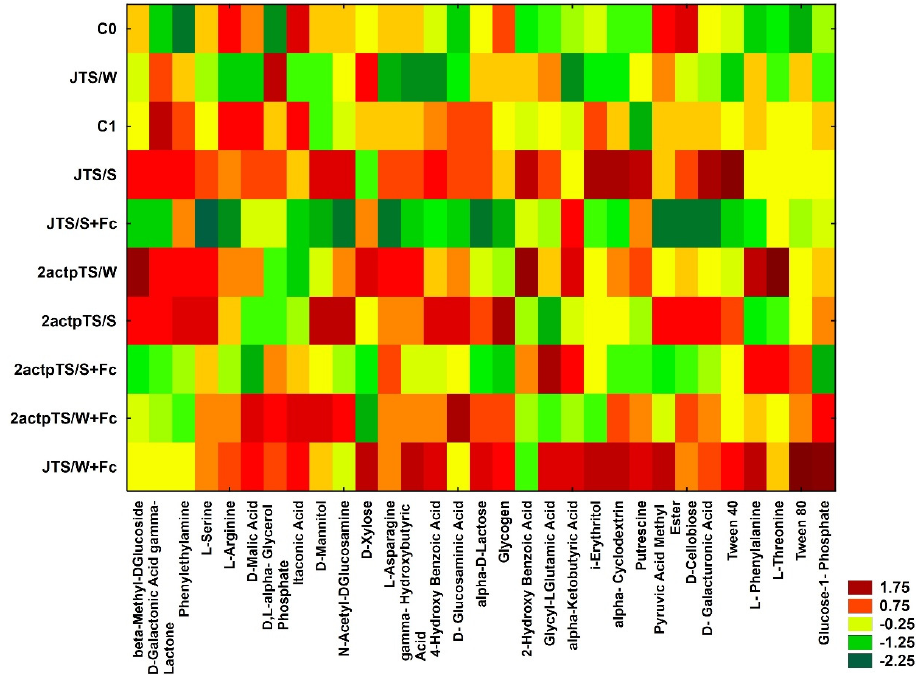
Figure 3. Heatmap based on the analysis of 31 carbon sources after a 96 h incubation of Biolog EcoPlates. Plates were replicated in triplicate.